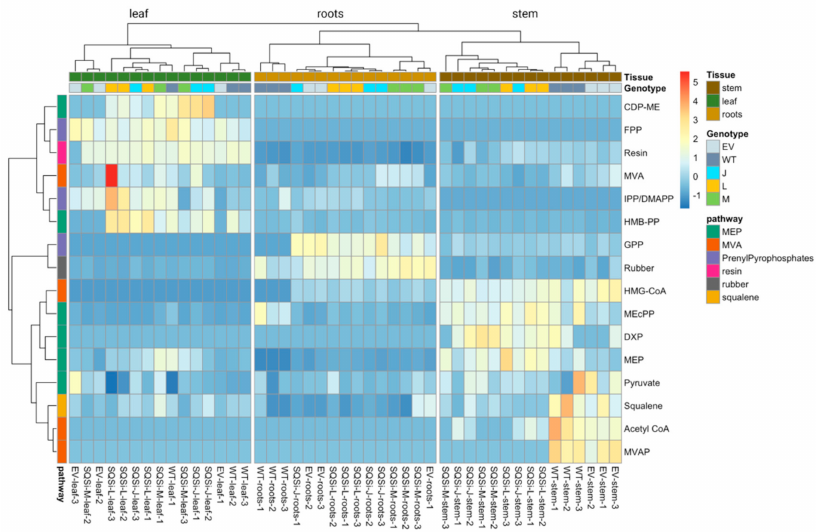
Figure 3. Multivariate analysis visualization of precursor and intermediate compounds involved in natural rubber and squalene biosynthesis across all control and SQSi lines and tissues. Individual samples with different genotype and tissue type appear on the vertical axis, and the pathway of each identified measured compound is represented in the horizontal axis. Relative abundance of targeted metabolites is represented by color; orange indicates high relative abundance, while blue indicates low abundance. Pearson’s correlation-based hierarchical cluster analysis indicates a strong separation across different tissue types (column-wise), while no clear clustering pattern was observed in terms of pathways (row-wise). The heatmap scale ranges from − 1 to 5 (data pre-treated with